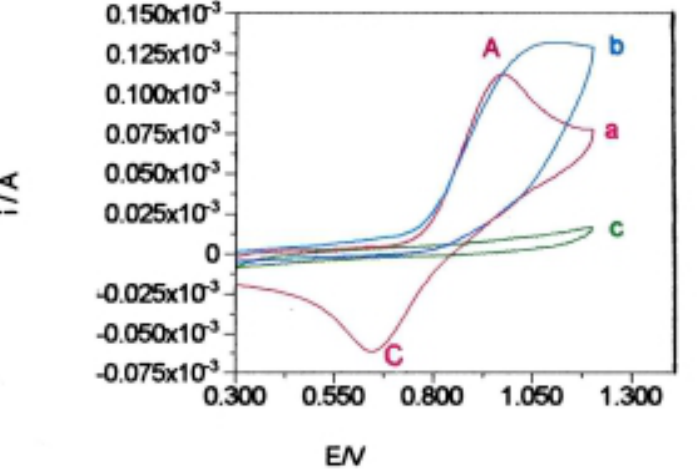
Figure 1 . (a) Cyclic voltammogram of 5 × 10 − 3 M sodium bromide, (b) cyclic voltammogram of 5 × 10 − 3 M sodium bromide in the presence of 5 × 10 − 3 M 1,3-indandione, (c) cyclic voltammogram of 1 × 10 − 3 M 1,3-indandione. Working electrode: glassy